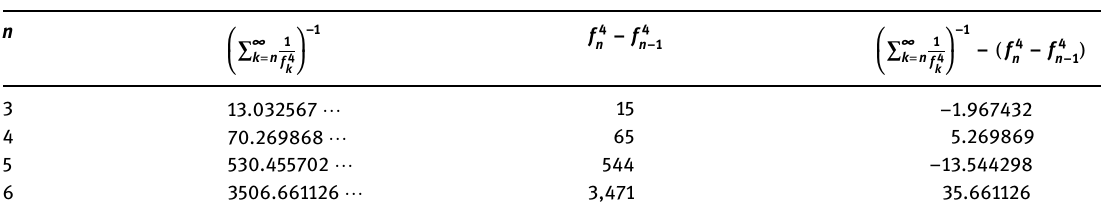
Table 1: The values of h n for 3 ≤ n ≤ 6